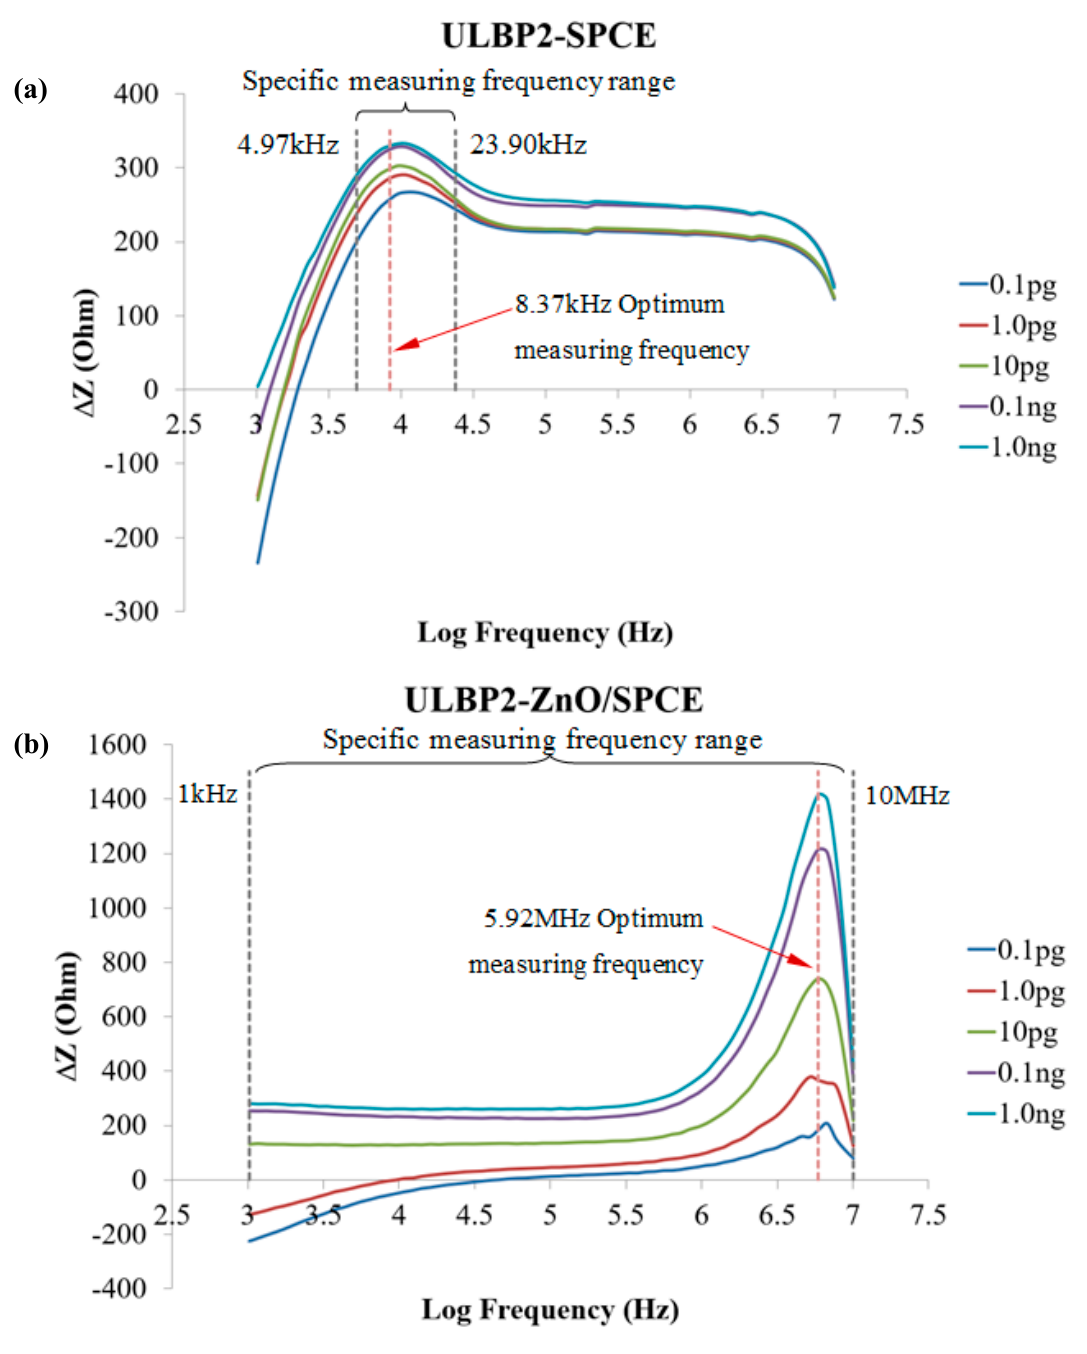
Figure 8. The spectrum for the impedance response of the immunosensors to the ULBP2 antigen at various concentrations: ( a ) ULBP2-SPCE immunosensor: There is an optimal measurement frequency (8.37 kHz) and a specific measurement frequency range (4.95–23.90 kHz). ( b ) ULBP2-ZnO /